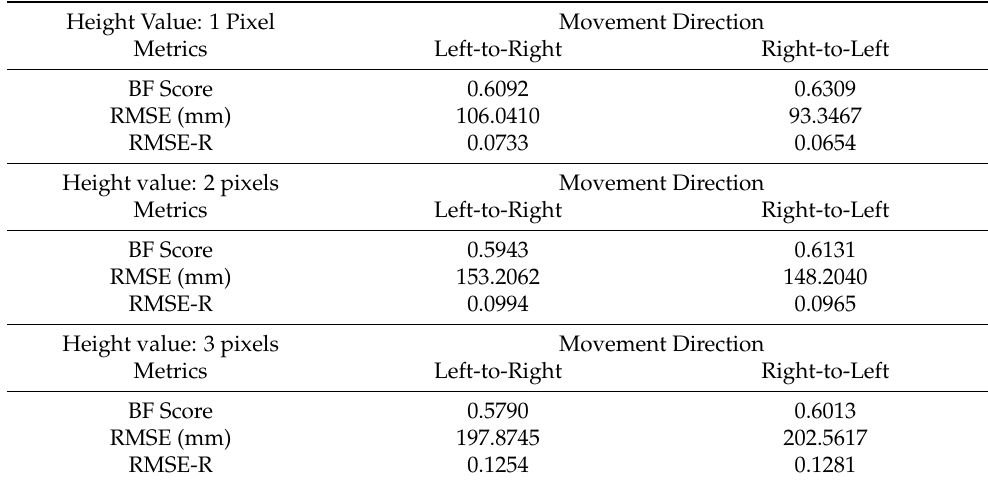
Table 8. Synthetic combined radial and linear motion blur performance.